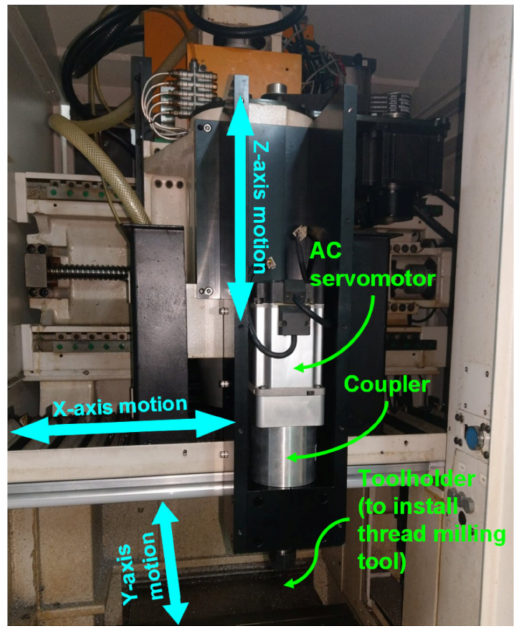
Figure 3. Computer numerical control (CNC) milling machine used in this